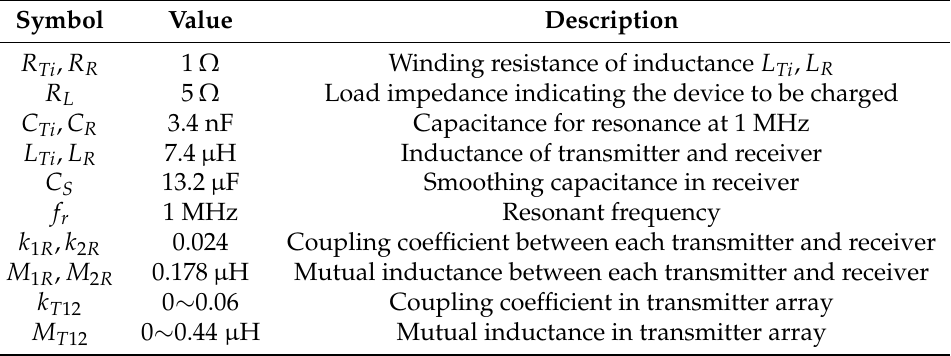
Table 2. Parameters for the simulation and experiment.